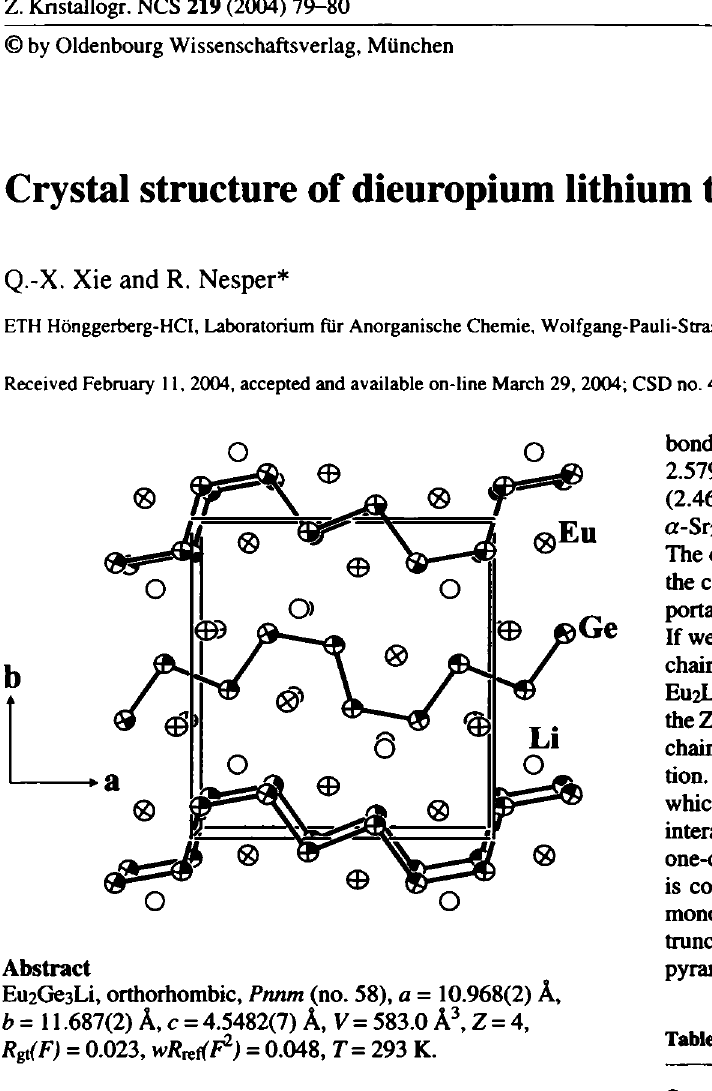
Table 1. Data collection and handling.